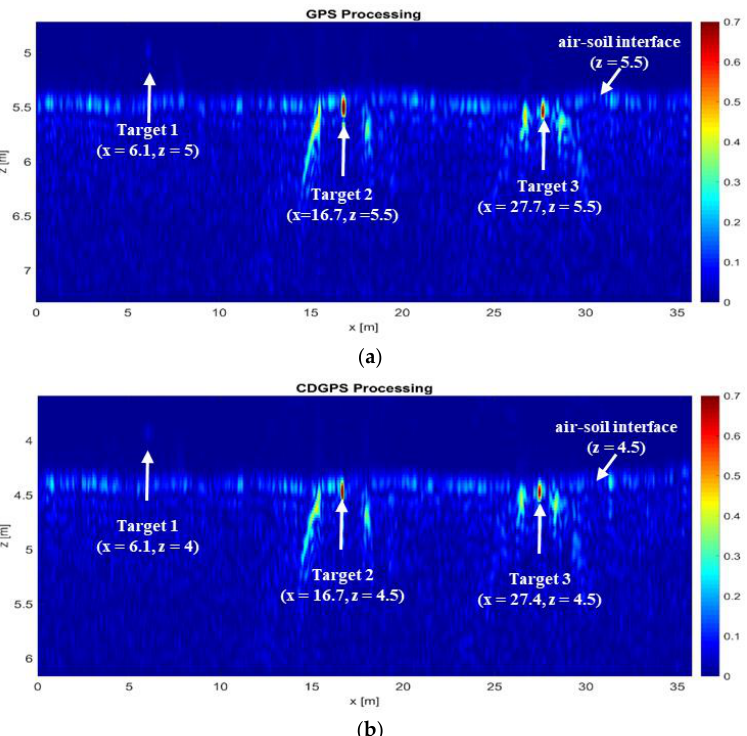
Figure 11. Tomographic images Test 1-Track 1 obtained by Shift and Zoom Truncated Singular Value Decomposition (TSVD) algorithm: ( a ) GPS based motion compensation (MoCo); ( b ) CDGPS based MoCo. Remote Sens. 2020 , 12 , x FOR PEER REVIEW